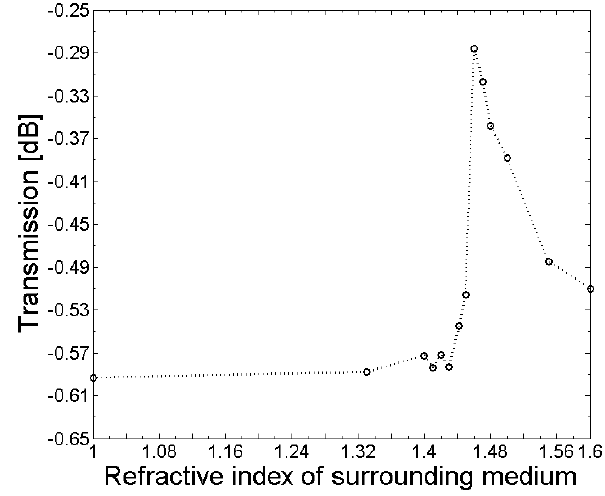
Figure 12. Dependence of the amplitude of the LPG transmission loss dip on the refractive index of the fiber surroundings.